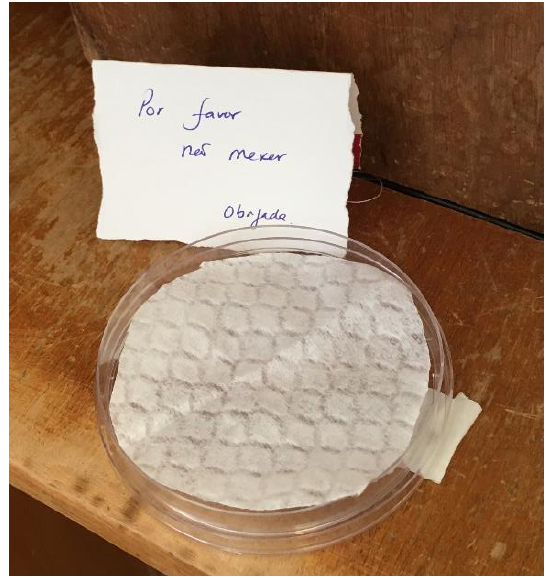
Figure 2. Example of one of the EDCs placed at the assessed locations. A request for non-disturbance accompanies the EDC.